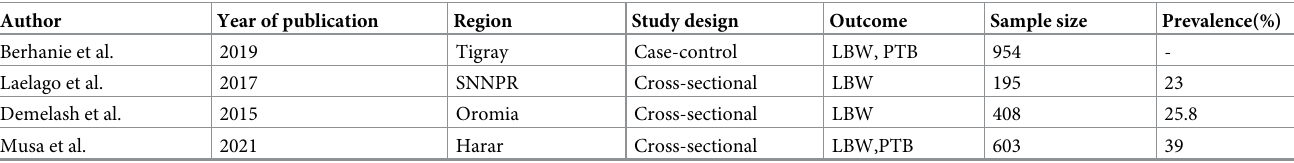
Fig 1. PRISMA flow chart for selection of studies publication. https://doi.org/10.1371/journal.pone.0275836.g001 Table 1. Characteristics of 17 included studies in the meta-analysis of IPV and adverse birth outcomes, Ethiopia